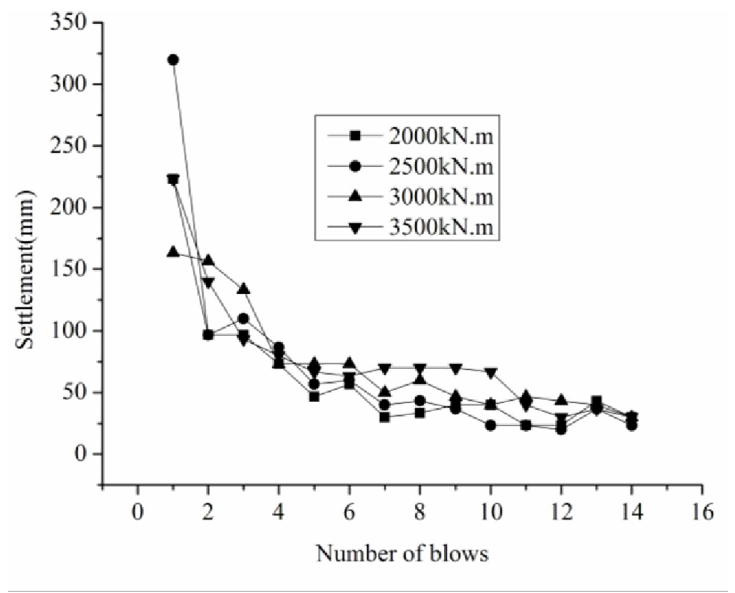
Fig 8. The tamping settlement curve with varying tamping energy.